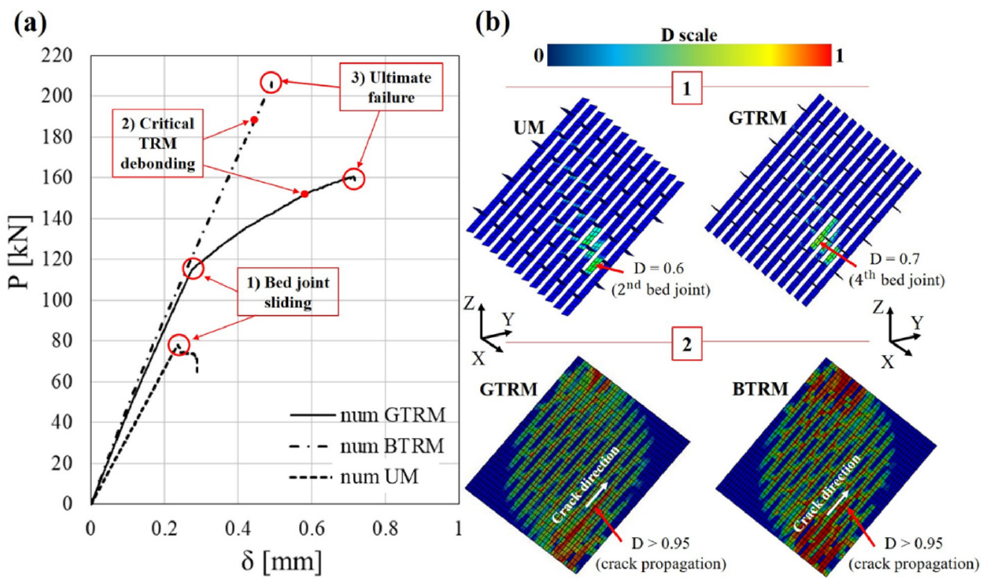
Figure 14. ( a ) Numerical load vs displacement curves; ( b , part 1) damage distribution in masonry bed and head joints; ( b , part 2) damage distribution in wall–TRM interface joint.